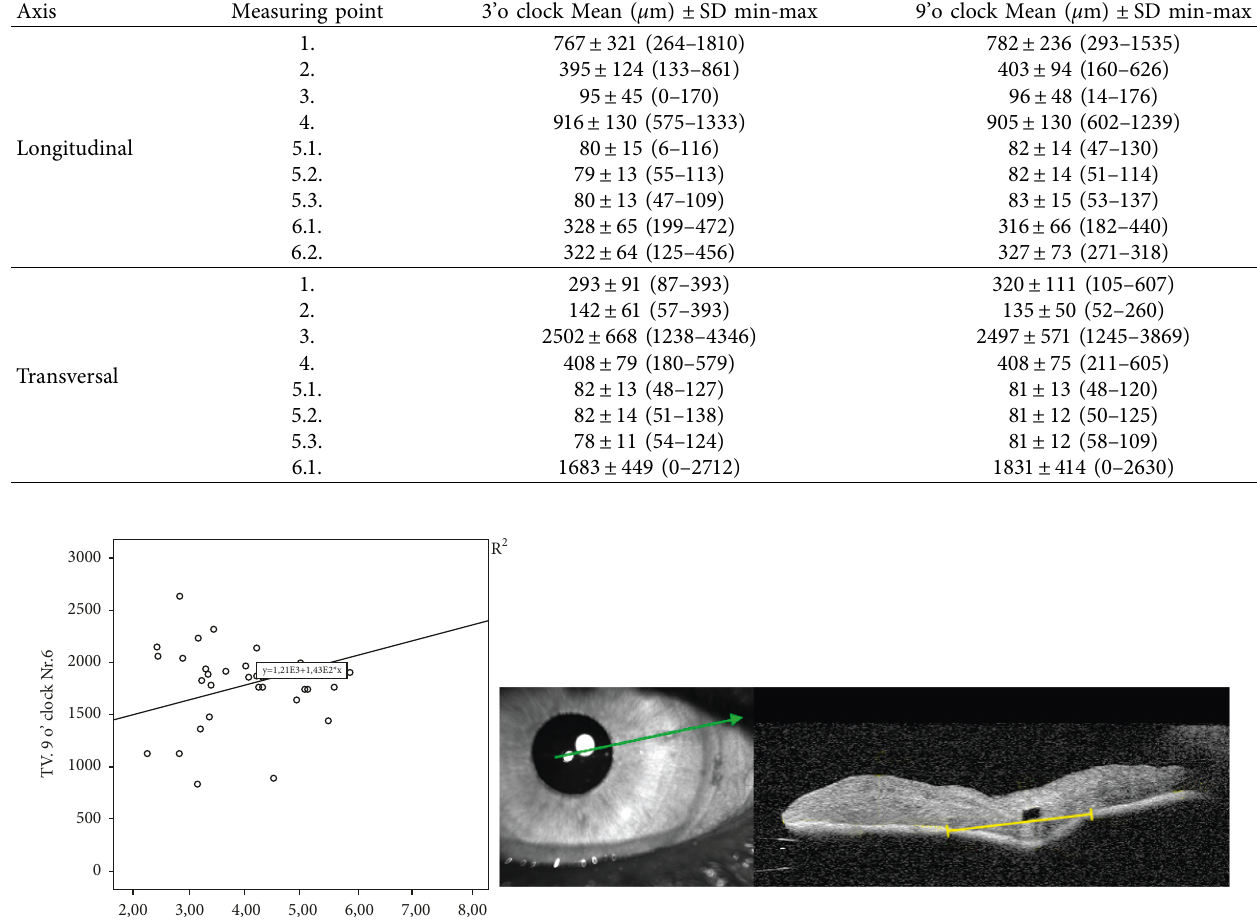
Table 2: All measured points as described in the method sections for the longitudinal and transversal orientation for the 3’o clock position and 9’o clock position.